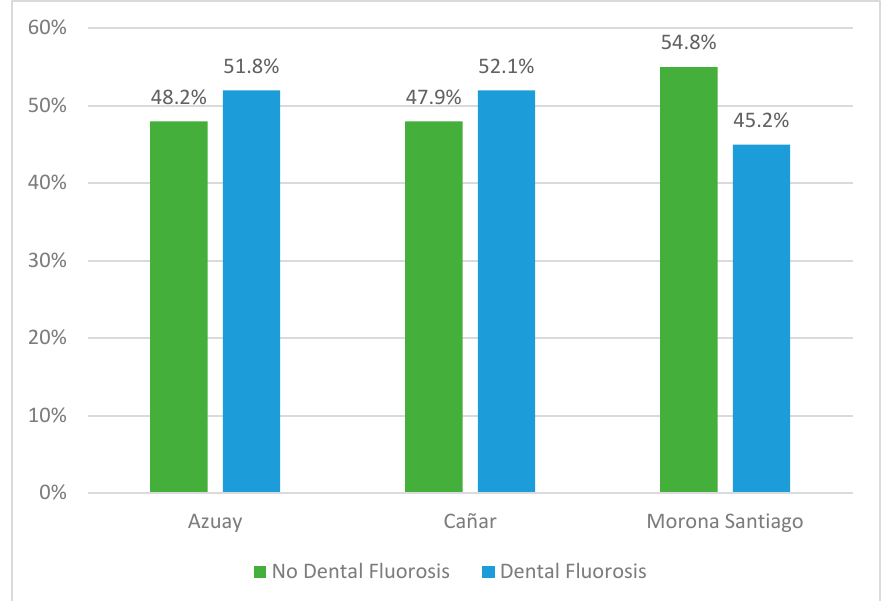
Figure 1. Prevalence of Dental Fluorosis by province.